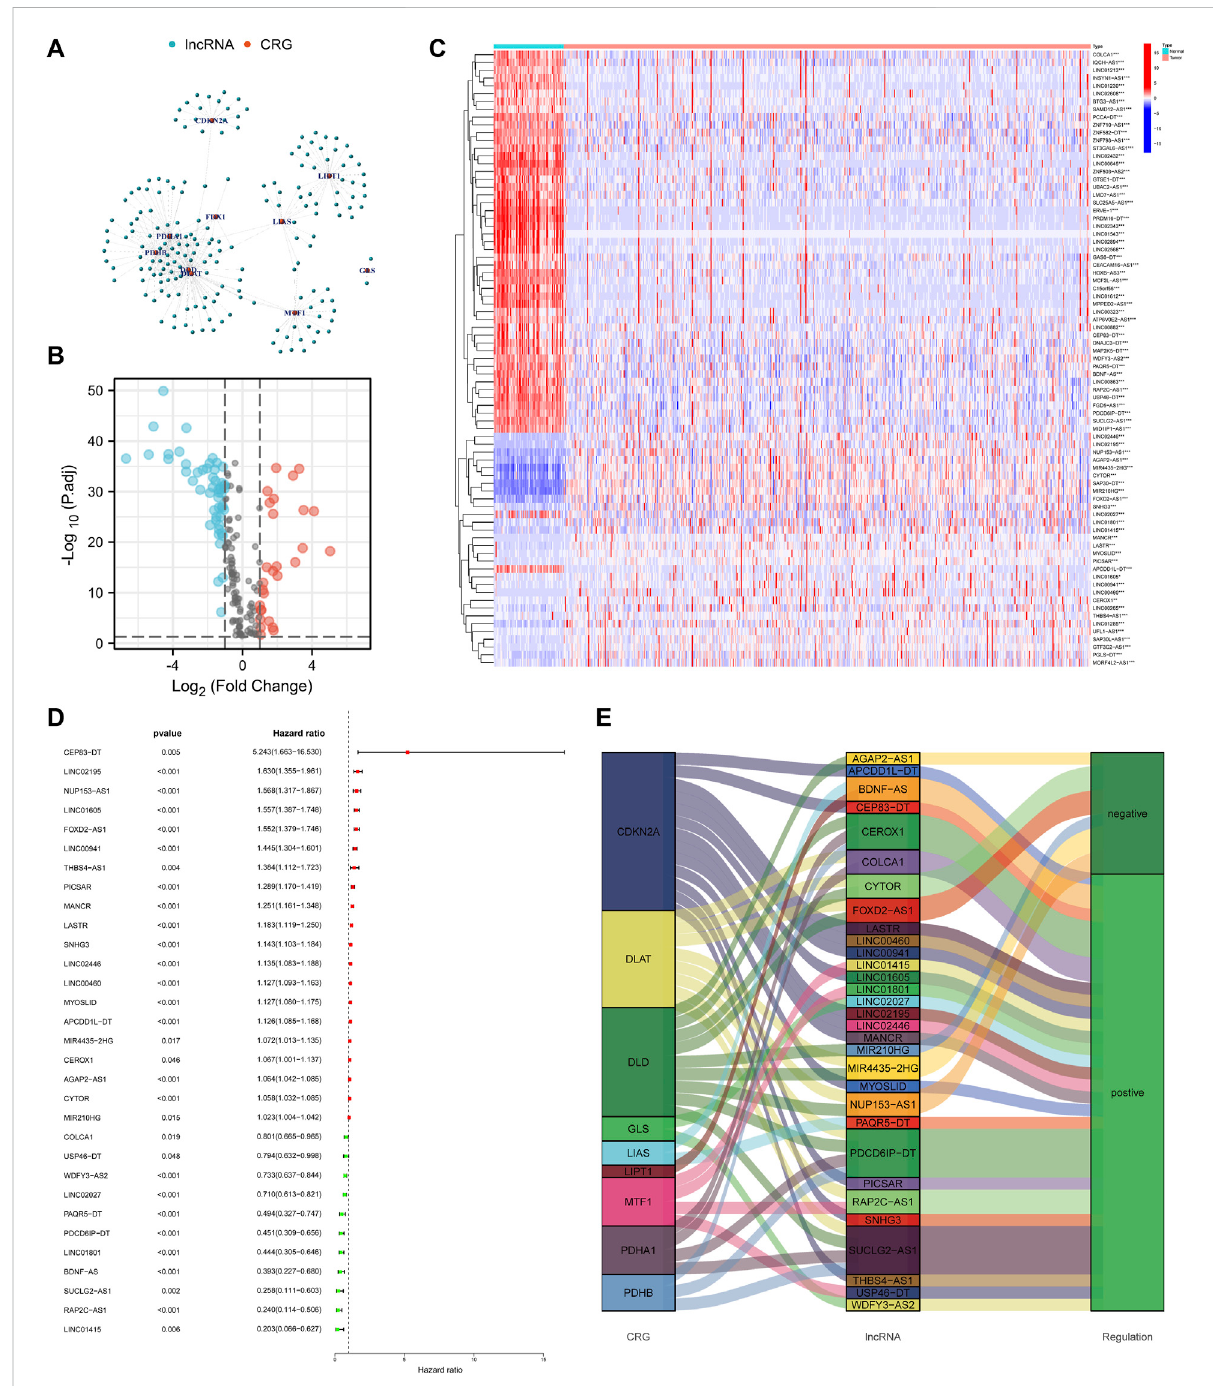
FIGURE 2 Selection of the cuproptosis-related prognostic lncRNAs differentially expressed in the KIRC. (A) Network of cuproptosis-related mRNAs and lncRNAs. (B) Volcano plot to identify differentially expressed lncRNAs. (C) Expression pro fi le of the differentially expressed lncRNAs. (D) Univariate COX regression analysis to select prognostic lncRNAs. (E) Sankey diagram to visualize the relevance between mRNAs and